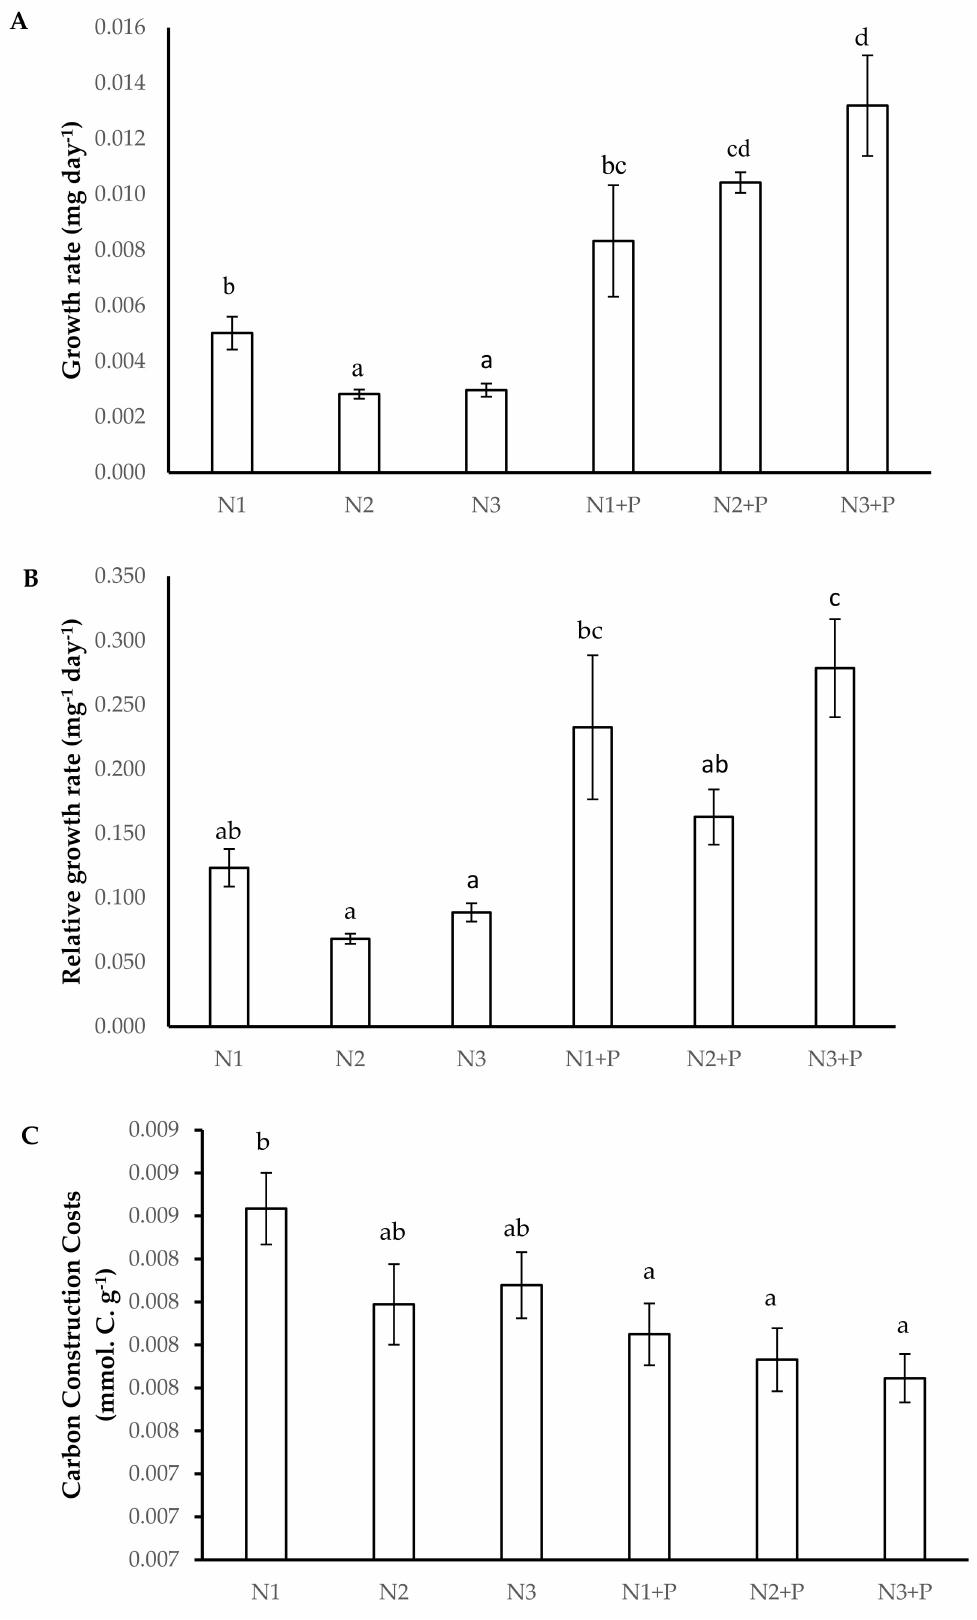
Figure 1. Growth kinetics (( A ). Growth rate, ( B ). Relative growth rate, ( C ). Carbon construction costs) of 180-day-old V. nilotica saplings grown in Ukulinga Farm soils. Values represent the mean ± SE, based on n = 5. Significant differences ( p < 0.05) among treatments are denoted by different superscript